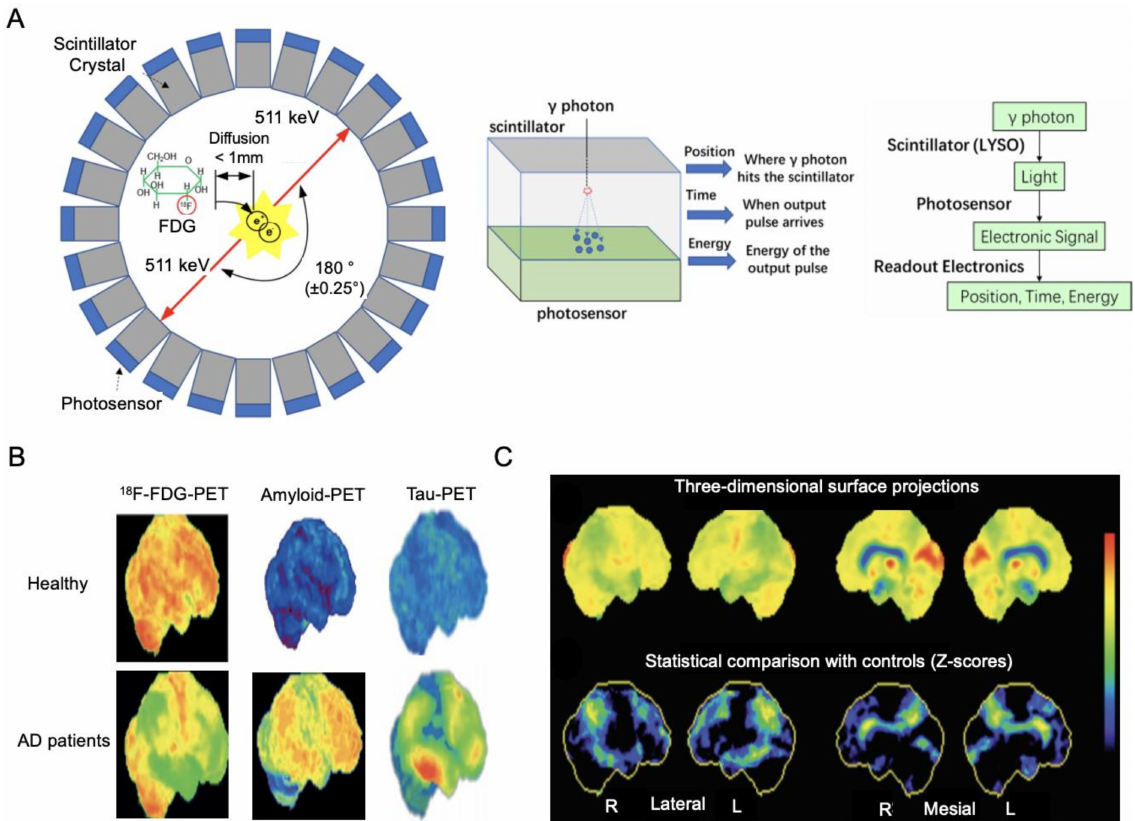
Figure 3. FDG-PET imaging. ( A ) Structure of PET detector and detection flow chart. Adapted from [45] with permission from MDPI. ( B ) Comparison of 18 F-FDG-PET, amyloid-PET, and tau-PET images from healthy controls (top row) and individuals with late-onset AD (bottom row). Adapted from [44] with permission from Elsevier. ( C ) A 3D surface projection of 18 F-FDG PET findings in AD (top row) and a statistical comparison with a healthy control population; green or yellow shows high deviation and black or blue shows no or low deviation (bottom row). Adapted from [53] with permission from